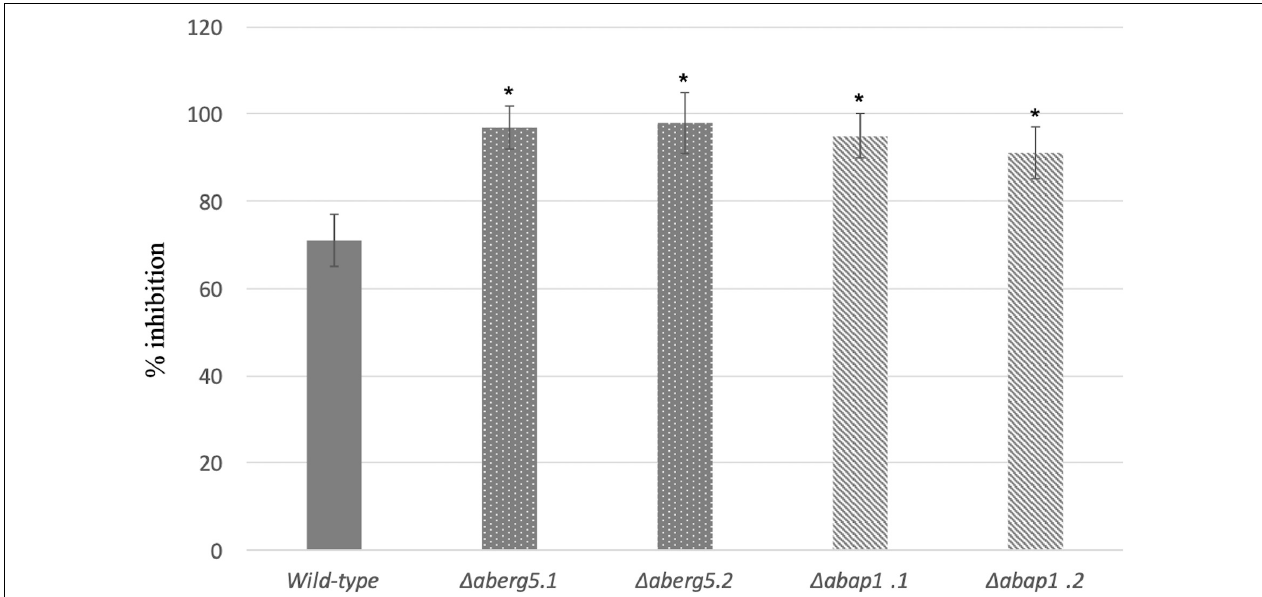
FIGURE 3 | Growth inhibition rates of the wild-type strain and AbErg5 and AbAp1 deficient mutants (two transformants per genotype) exposed to 100 µ M brassinin. The results show the percentages of inhibition in treated samples compared to the control. Fungal growth was recorded using a nephelometric reader from microplate wells containing standard PDB medium supplemented with brassinin or DMSO and inoculated with conidia (10 5 mL - 1 ). Each genotype was analyzed in triplicate and the experiments were repeated three times per growth condition. Error bars indicate standard deviations. Asterisks indicate a significant difference between the mutant and the parental isolate (Student test, P <